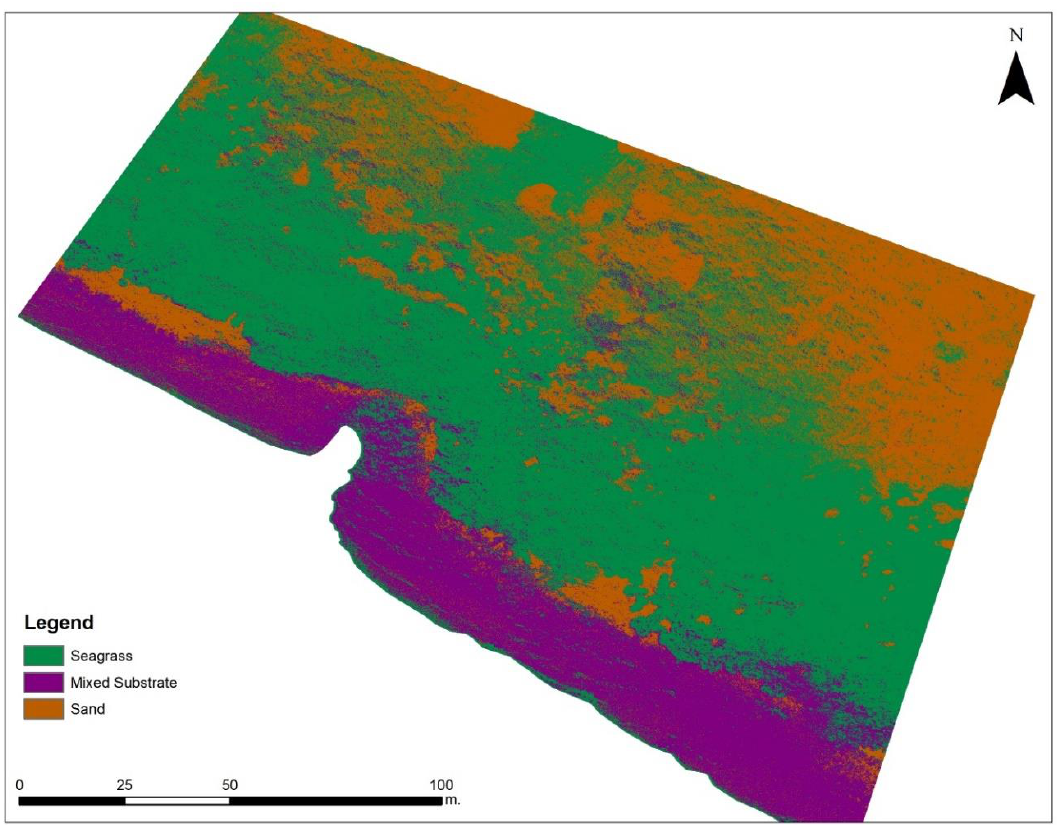
Figure 7. Classified map of the second case study on 18 April 2019 (non-optimal day).